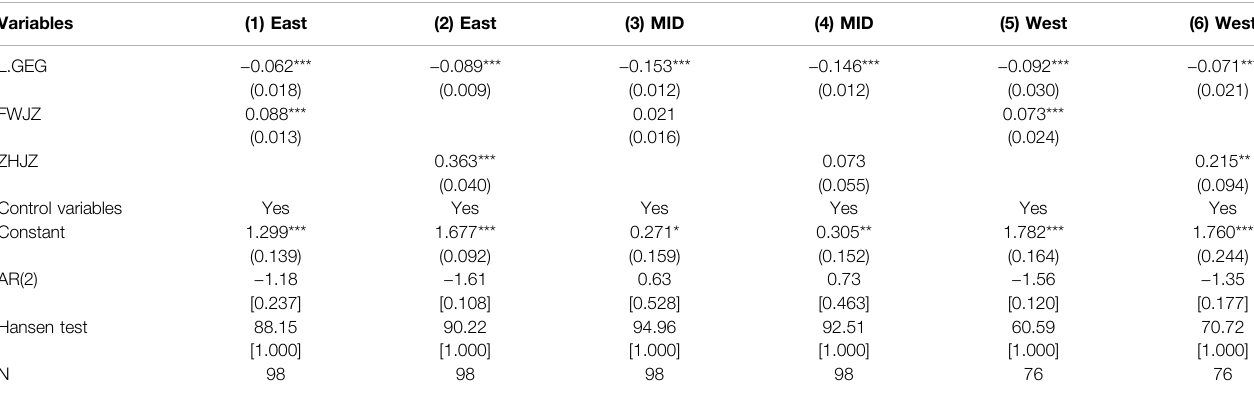
TABLE 9 | Regional heterogeneity results under service competition and comprehensive competition.